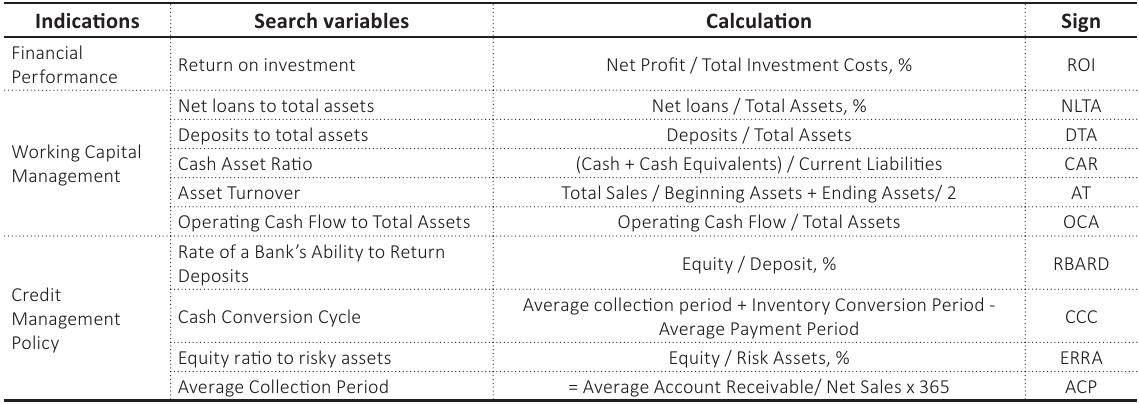
Source: Data obtained from the ASE (2021).